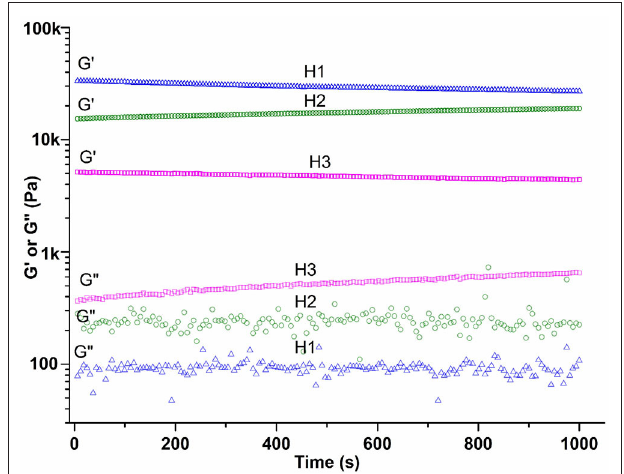
FIGURE 9 | Frequency dependence of the dynamic storage modulus (G ′ ) and the loss modulus (G ′′ ) of hydrogels with different polymer contents (H1, 20%; H2, 15%; H3,